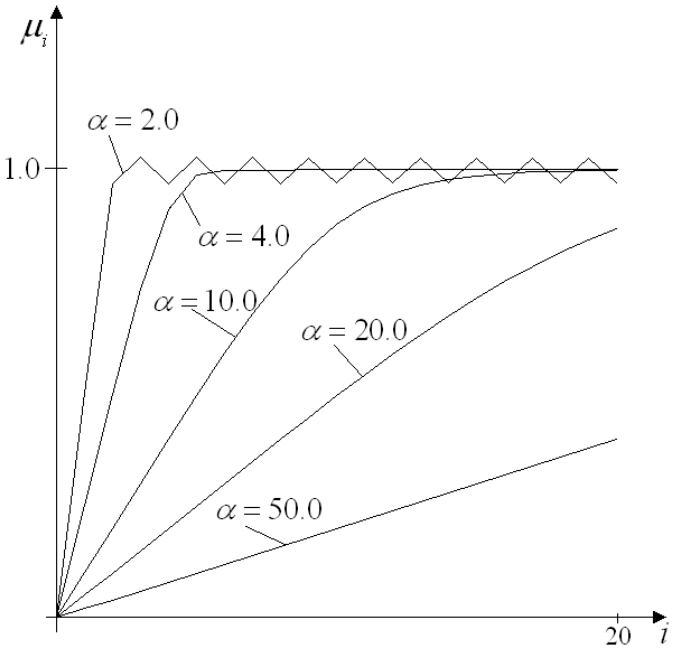
Figure A4. The constants µ i as a function of the index i ( i = 0,1,2, . . . ,20) for five selected values of α . For sufficiently large α , it is to be noticed that, for i → ∞ , µ i represents the temperature at x = ± 1. This is not true for α = 2.0.